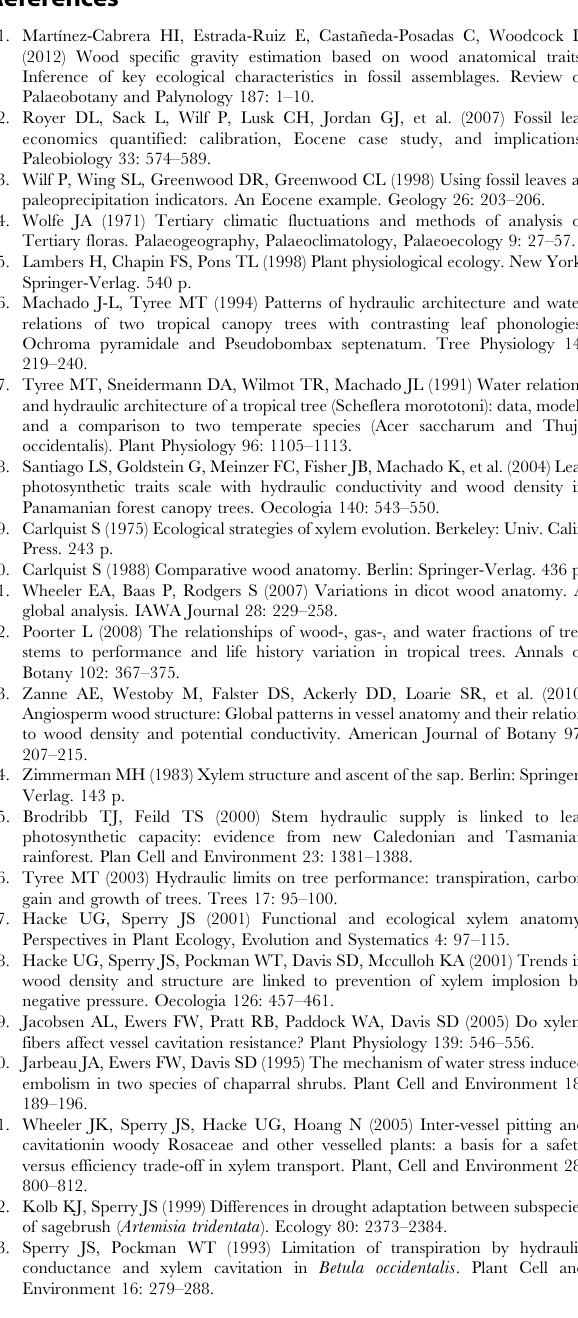
Table S1 Vessel dimensions data for each of the samples/morphotypes. Table S2 Sample means for each functional trait. Table S3 Individual measurements of implosion resis- tance and estimated cavitation resistance. Table S4 Trait loadings in the three first PC axes.